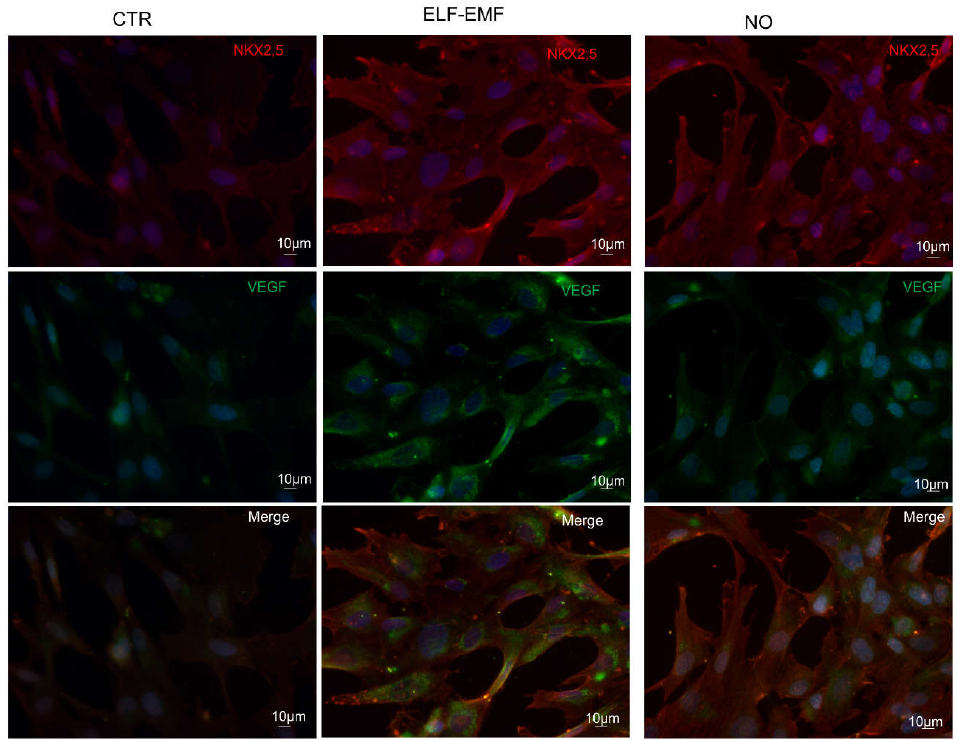
Figure 6. hAMSC protein expression by double indirect immunofluorescence analysis of NKX2‐5 (red) and VEGF (green): control cells (CTR), 5 days 7 Hz, 2.5 μT exposed cells (ELF‐EMF) and cells treated with 0.4 mM of Nitric Oxide (NO). Nuclei are counterstained with Hoechst (blue) ( n = 3).